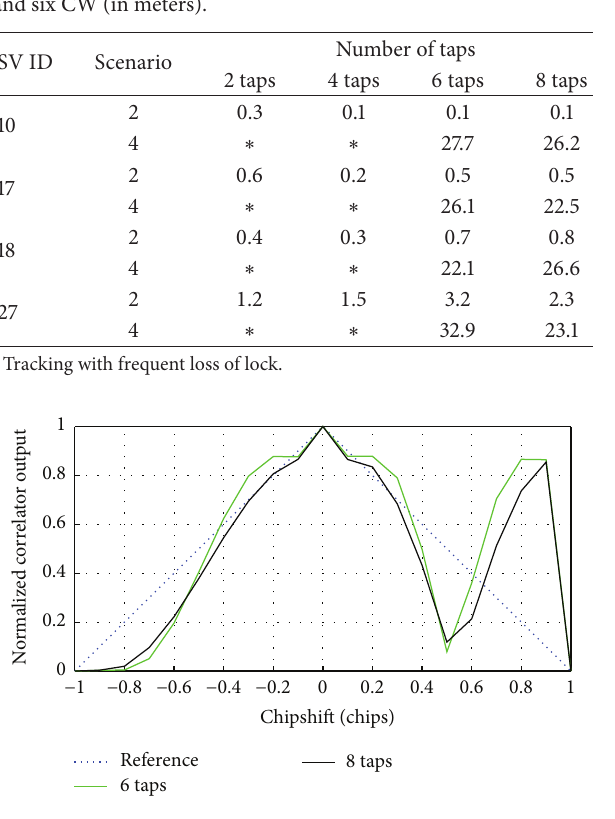
Figure 7: CCF distortions for PRN10—Scenario 4.